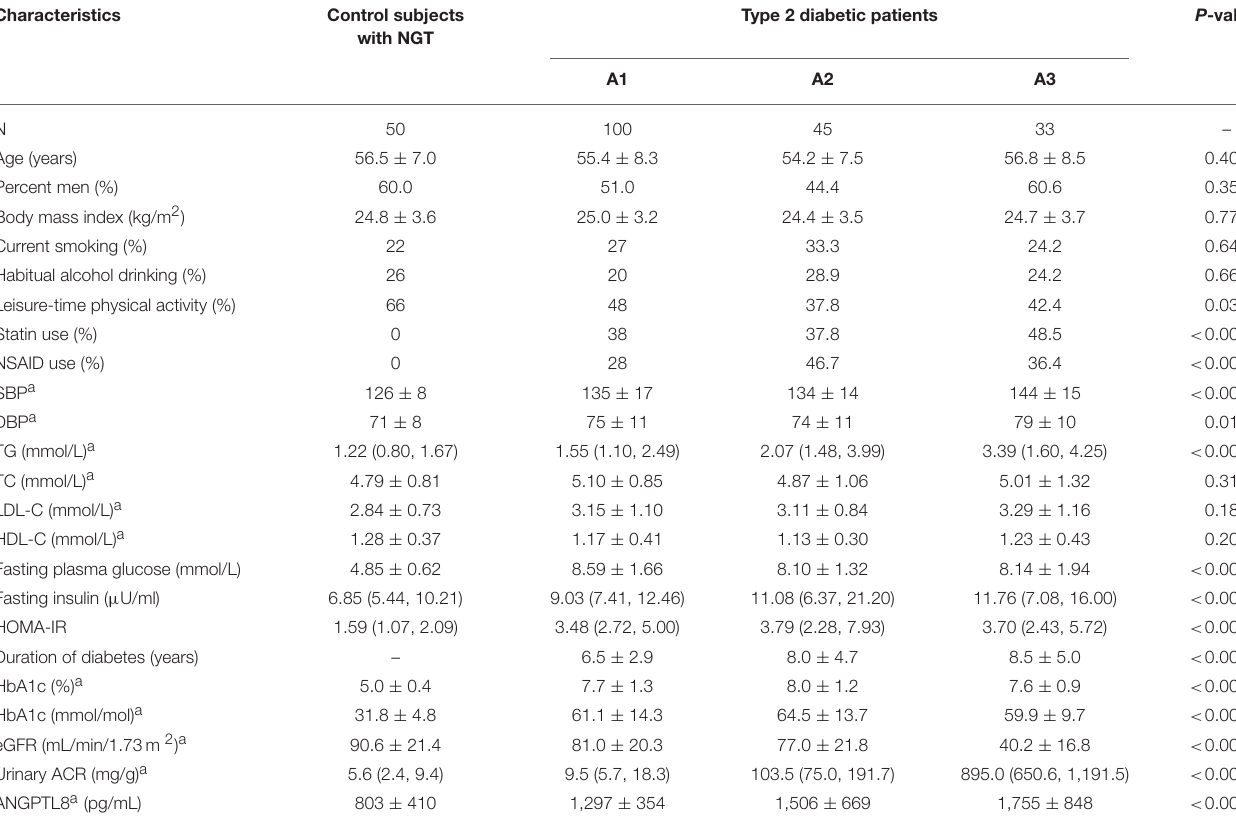
TABLE 1 | Clinical characteristics in control subjects with normal glucose tolerance (NGT), and T2DM patients with A1, A2, and A3.